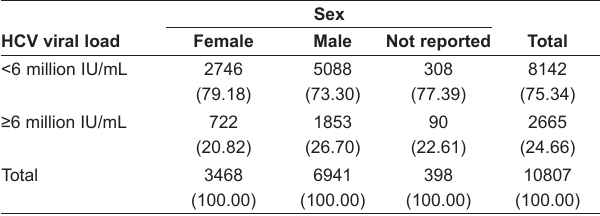
TABLE 2 Hepatitis C virus (HCV) genoptype 1 patients according to